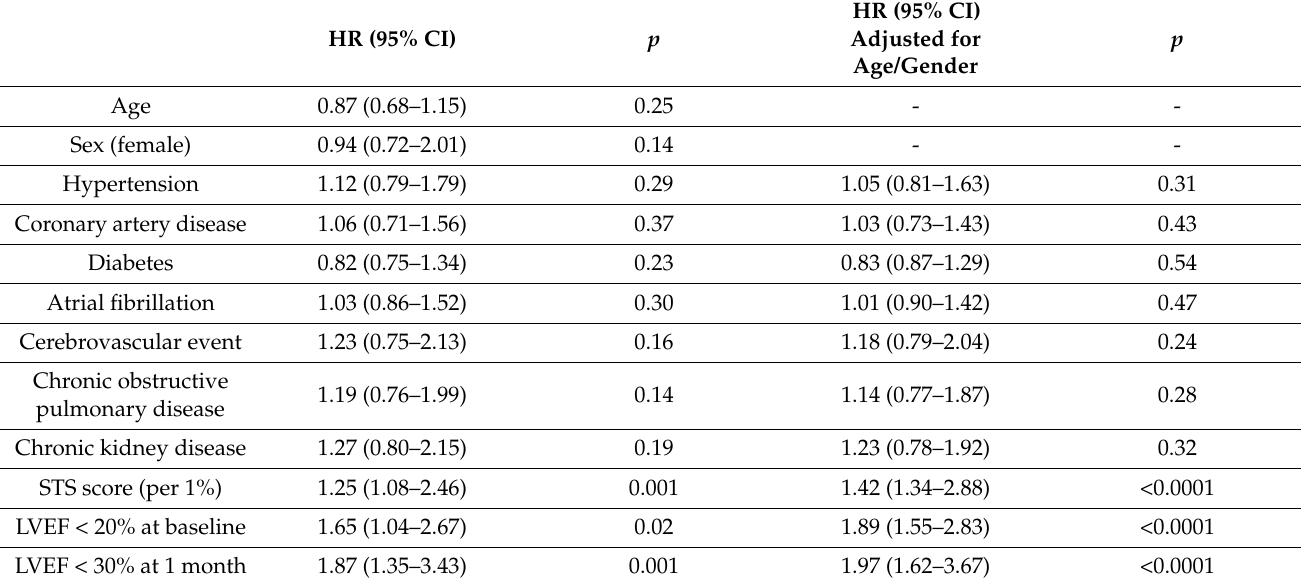
Table 6. Multivariable Cox model for all-cause